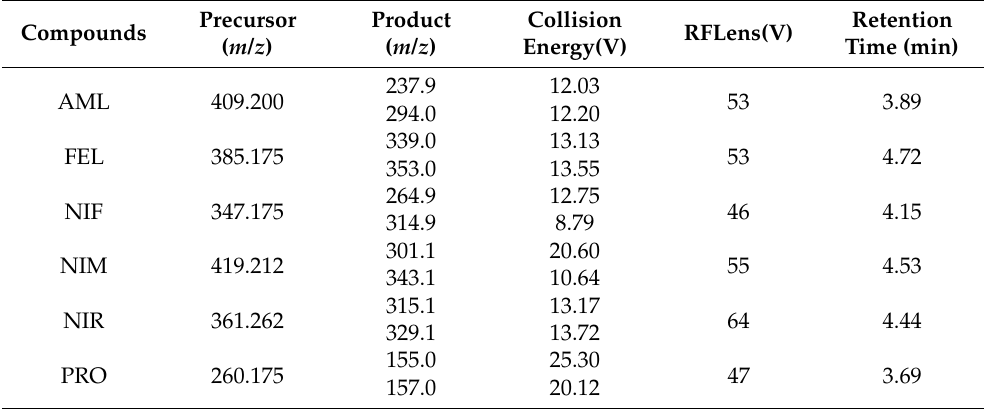
Table 5. The MS/MS fragment ions, fragmentor voltage, collision voltage, and retention time of the five calcium